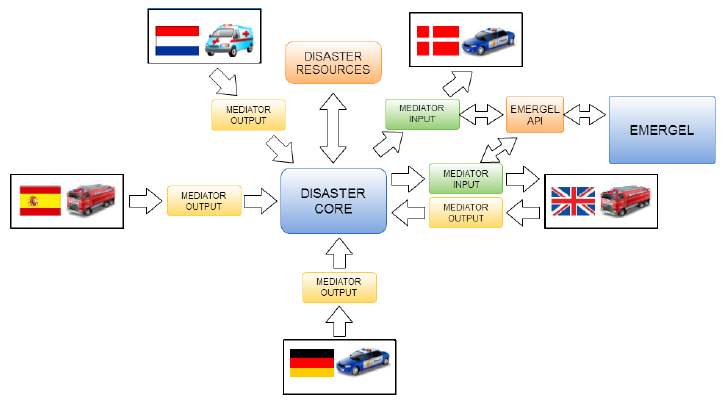
Figure 1. High-level overview of DISASTER software architecture. Each EMS is connected to its Mediator. DISASTER core provides generic functionalities to all